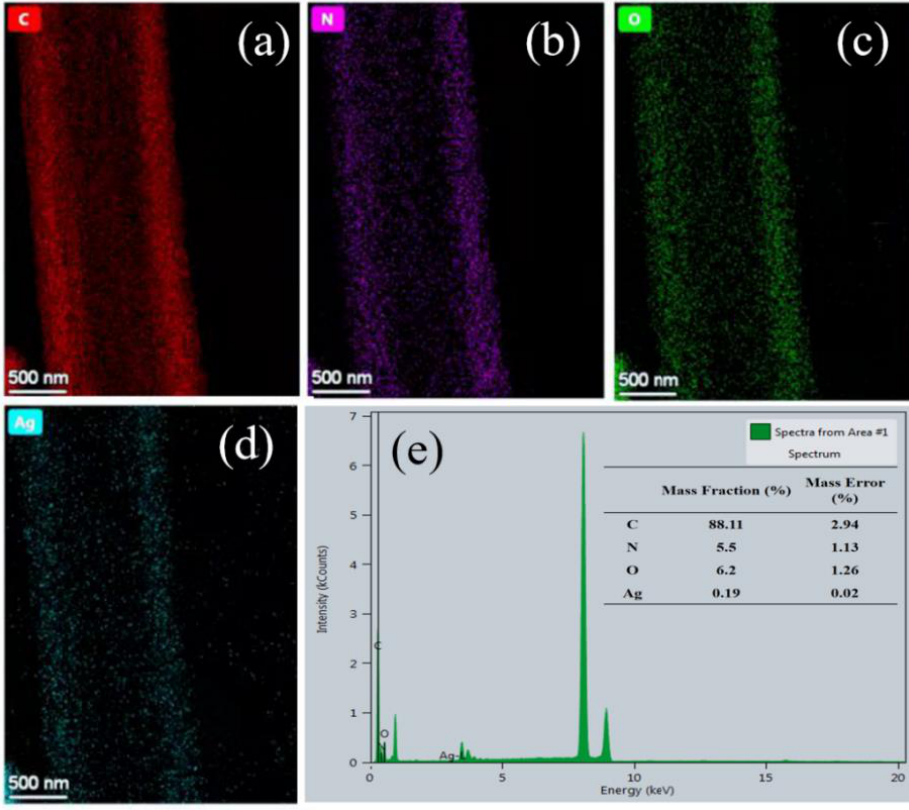
Figure 3. ( a – e ) EDS mapping diagram of AgNP-embedded TPU nanofiber membrane. The FTIR spectra (Figure 4a) indicated that the pure TPU nanofiber membrane had an N-H stretching vibration peak at 3330 cm −1 , a C-H stretching vibration peak at 2960 cm −1 , a -CH 2 symmetrical vibration peak at 2870 cm −1 , a free C=O stretching vibration peak at 1730 cm −1 , and a characteristic peak of hydrogen bonding carbonyl stretching vibration at 1700 cm −1 . Compared with those of pure TPU nanofiber membrane, the FTIR spectra of AgNP-embedded TPU nanofiber membrane showed no new absorption peak, indicating no new chemical bond between AgNPs and TPU matrix.